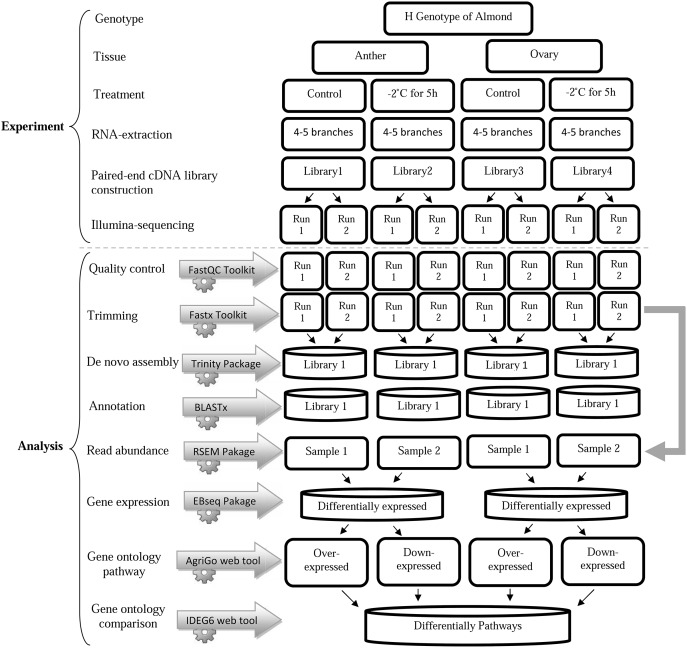
Our pipeline for RNA-seq analysis in almond under control and frost stress conditions.Two almond tissues (anther and ovary) were subjected to untreated and −2°C conditions. Following the RNA exteraction, cDNA library was constructed and sequencing was performed using an IIlumina platform. De novo transcript assembly was conducted after quality control and trimming the reads and then contigs were annotated. Transcript aboundance and differentially expressed genes were analyzed using RSEM and EBseq, respectively. Finally, gene ontology were determined for each set of genes in the DE list.